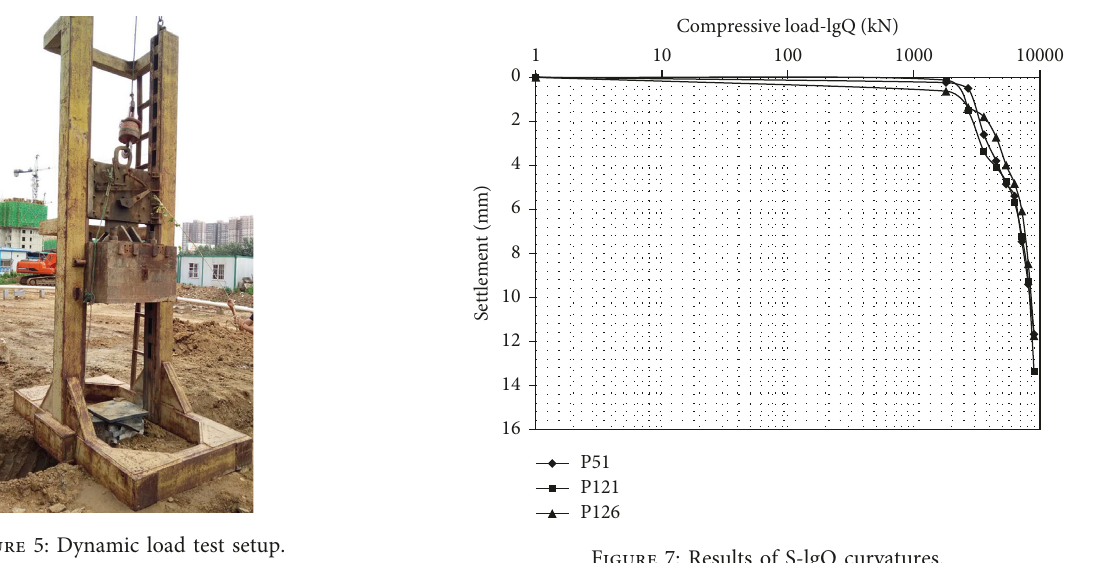
Figure 7: Results of S-lgQ curvatures.